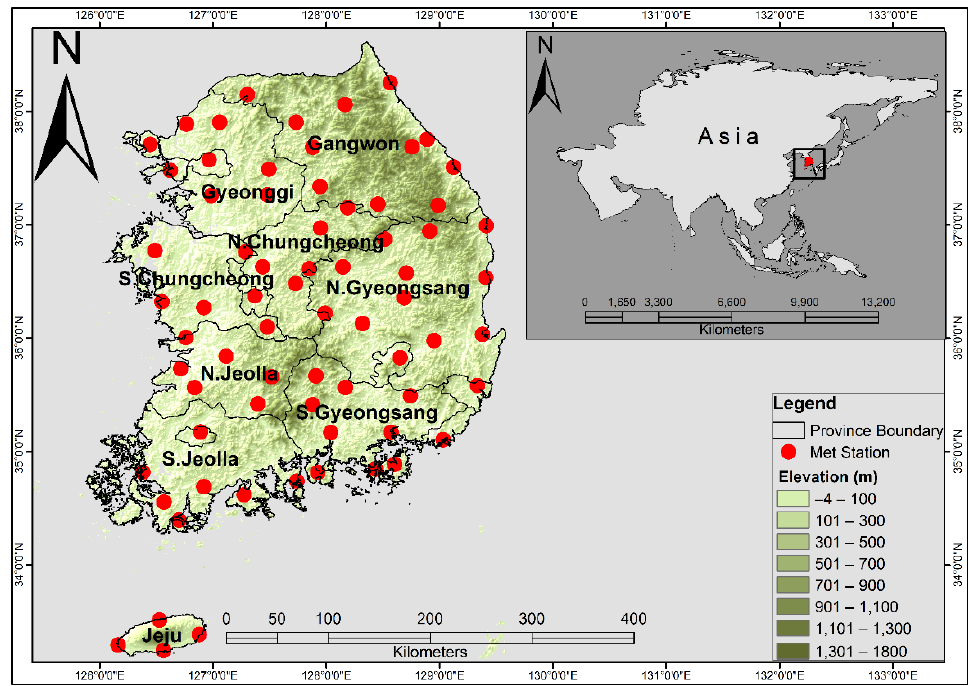
Figure 1. Map of South Korea with elevation and meteorological stations. Data